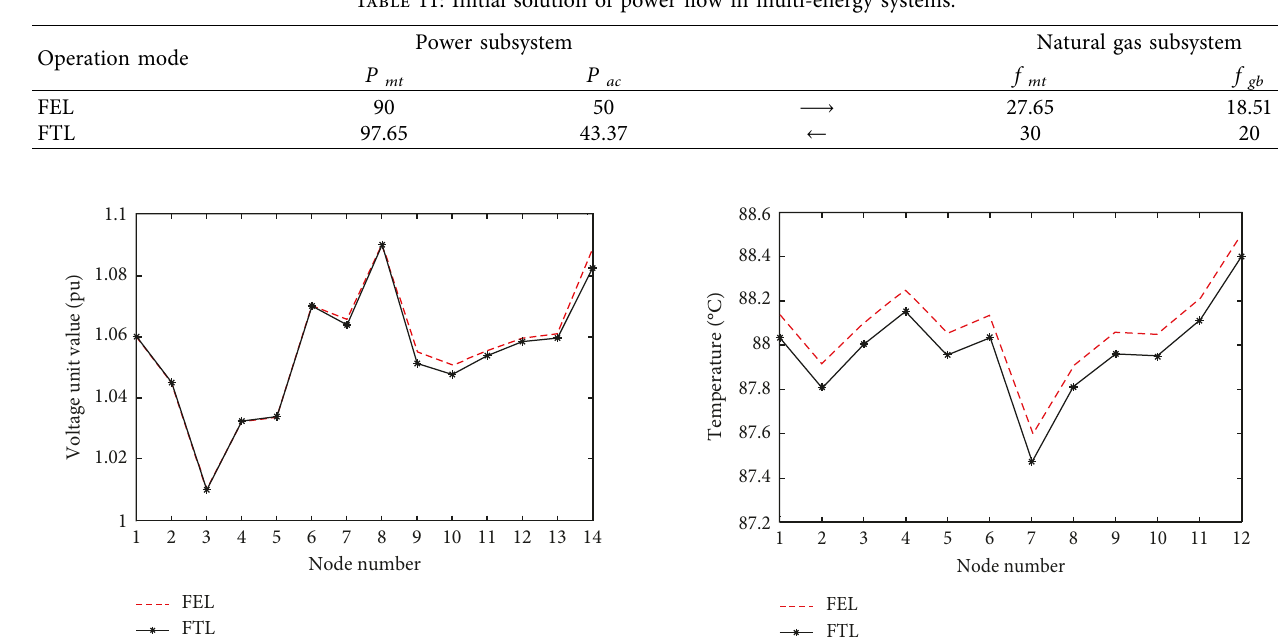
Figure 5: Water supply temperature at each node.